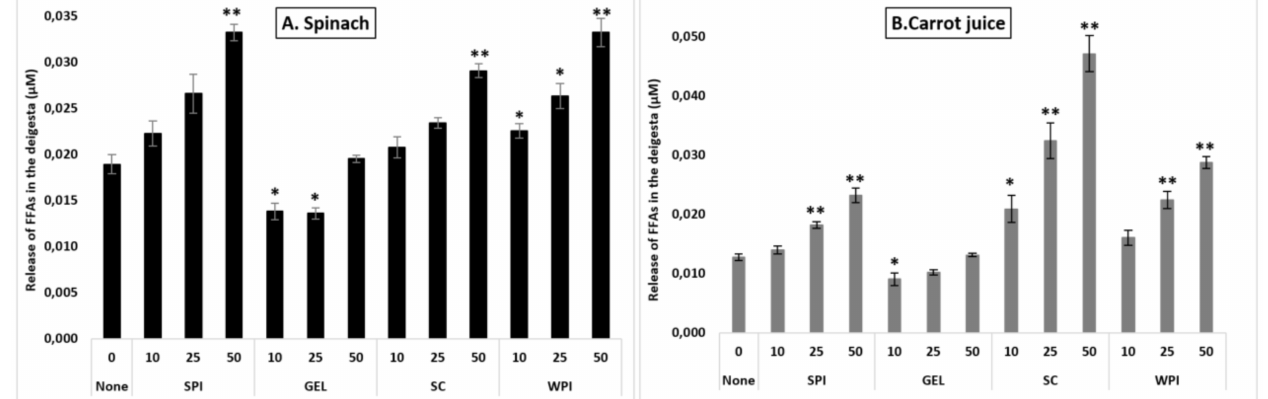
Figure 4. Influence of proteins on the release of free fatty acids (FFAs) during simulated GI digestion of spinach ( A ) and carrot juice ( B ). Carotenoid-rich matrices were co-digested in the presence of WPI, SPI, SC or GEL at various concentrations (0, 10, 25 and 50% of the RDA (approx. 60 g/d for human adults [35])), and the release of FFAs was evaluated at the end of GI digestion (Cayman’s Free Fatty Acid Fluorometric Assay). Values represent means ± SD of n = 4. Columns labelled with either * ( p < 0.05) or ** ( p < 0.001) were significantly different from the control condition (no added